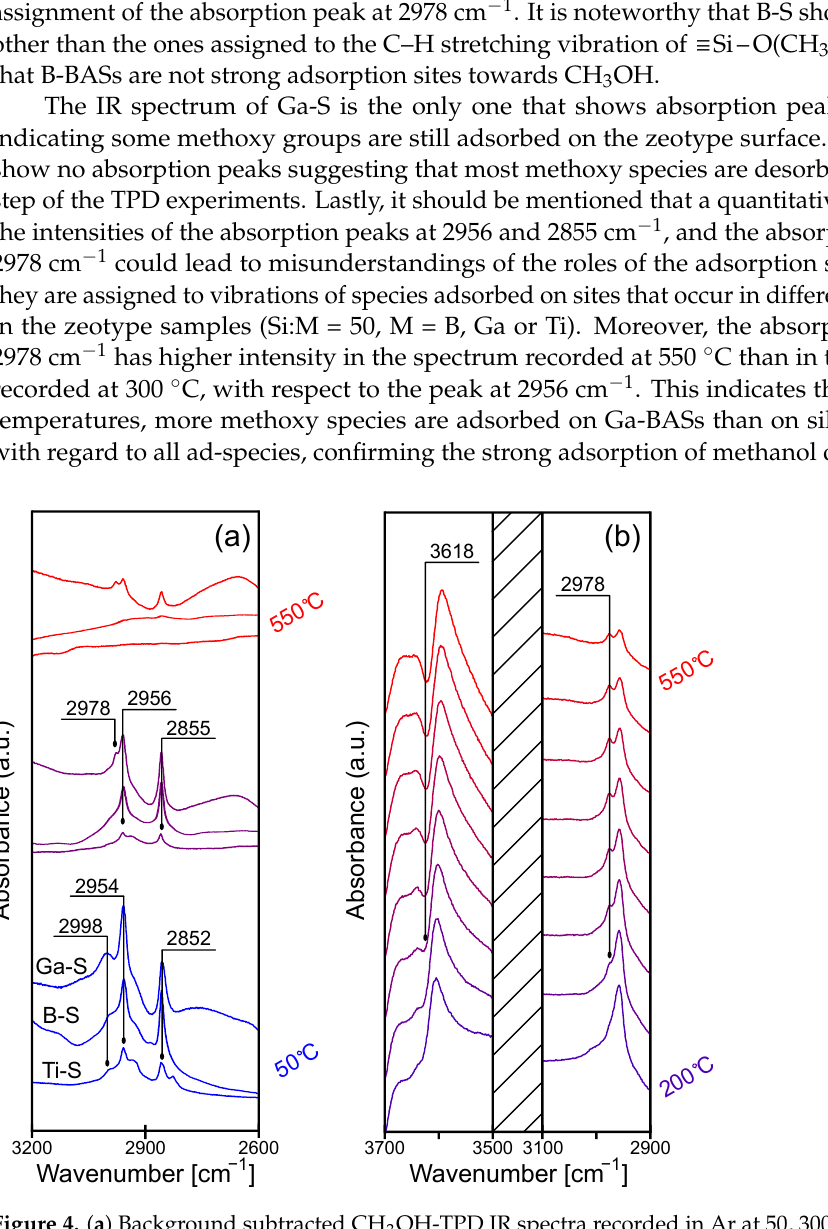
Figure 4. ( a ) Background subtracted CH 3 OH-TPD IR spectra recorded in Ar at 50, 300 and 550 ◦ C of the Ti-, Ga- and B-silicalite samples in the H + -form. The background spectra were taken in Ar at room temperature after the 10% O 2 /Ar pretreatment and before CH 3 OH adsorption; ( b ) background subtracted CH 3 OH-TPD IR spectral series recorded in Ar from 200 to 550 ◦ C (steps of 50 ◦ C) of the Ga-silicalite sample in the H + -form. The background spectrum was taken in Ar at room temperature after the 10% O 2 /Ar pretreatment and before CH 3 OH